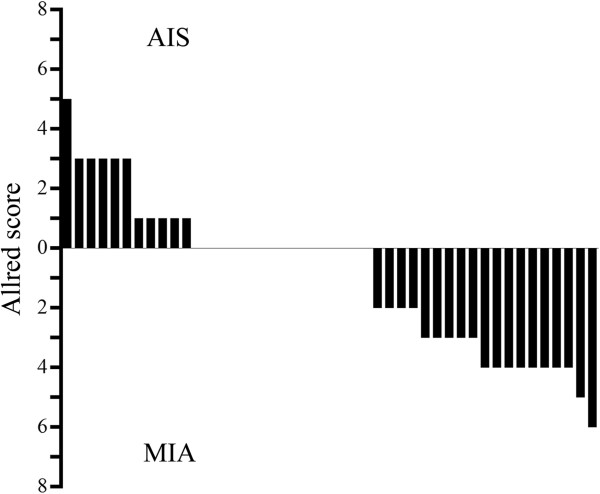
Allred score system devised to score results from immunohistochemical tests of TGF-β1. Differences in TGF-β1 immunostaining between AIS and MIA scored using the Allred method; *P <0.05.